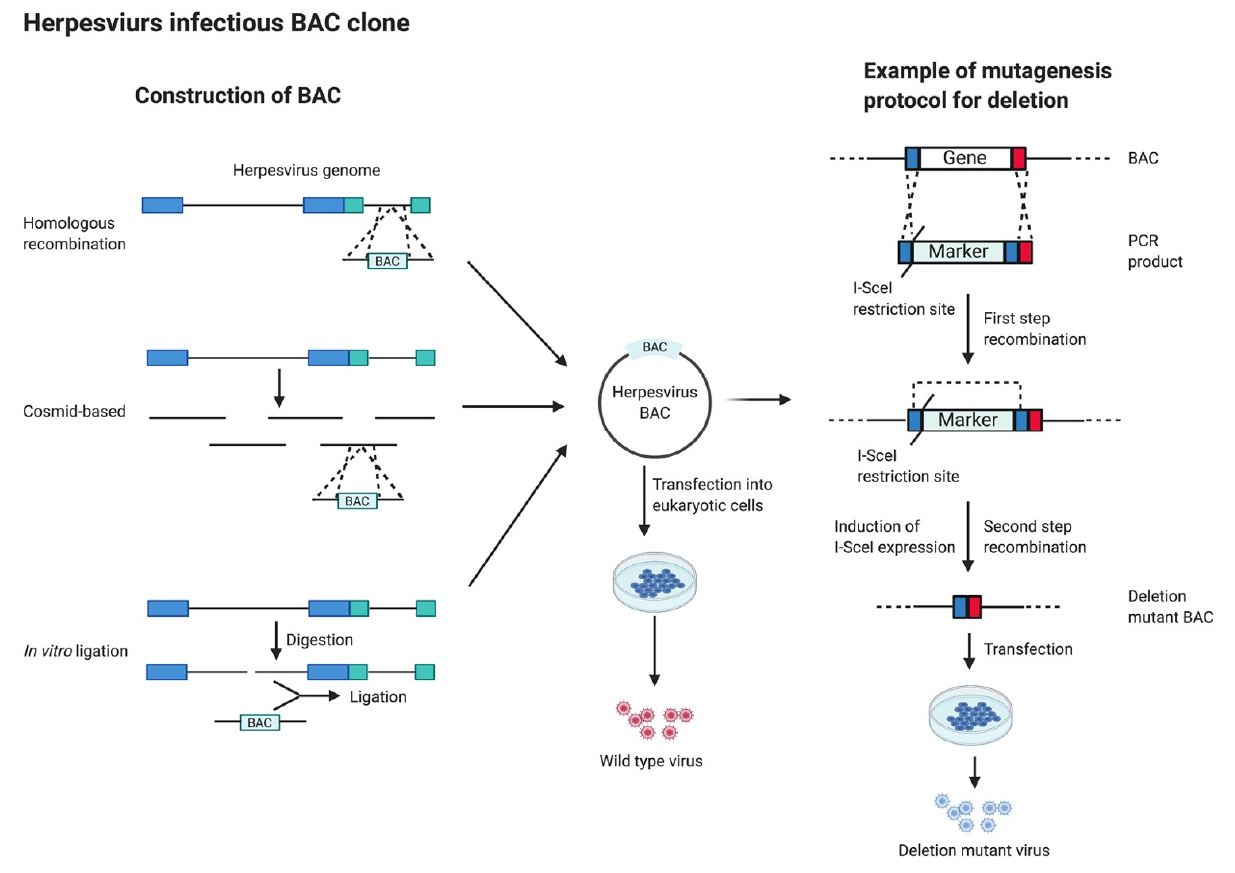
Figure 4. Generation of virus BAC clone and its application to herpesvirus mutagenesis.